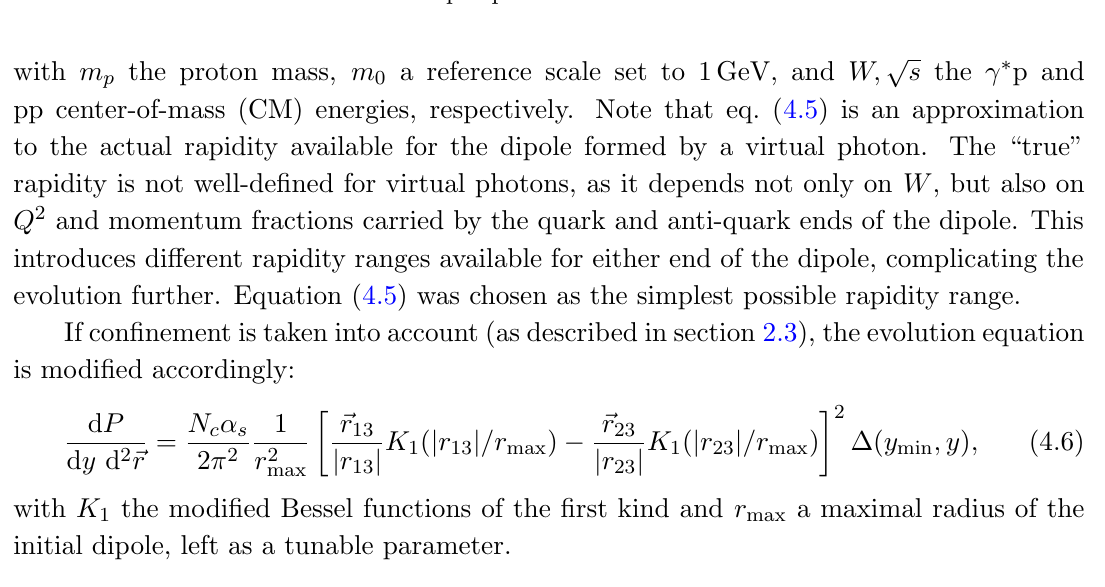
Table 1. The input parameters used in this